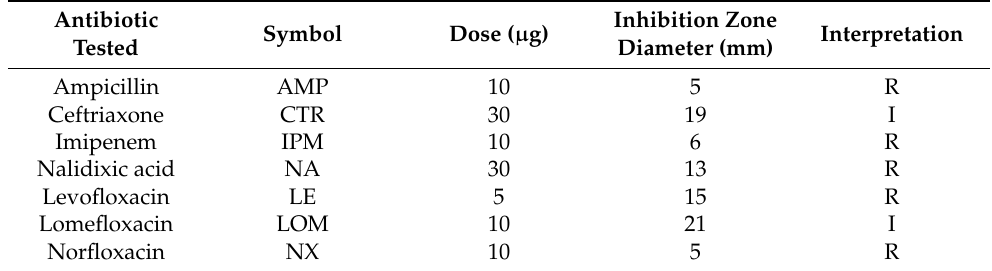
Table 2. Antibiotic susceptibility test results of the Janthinobacterium sp. SLB01 strain by the disk diffusion